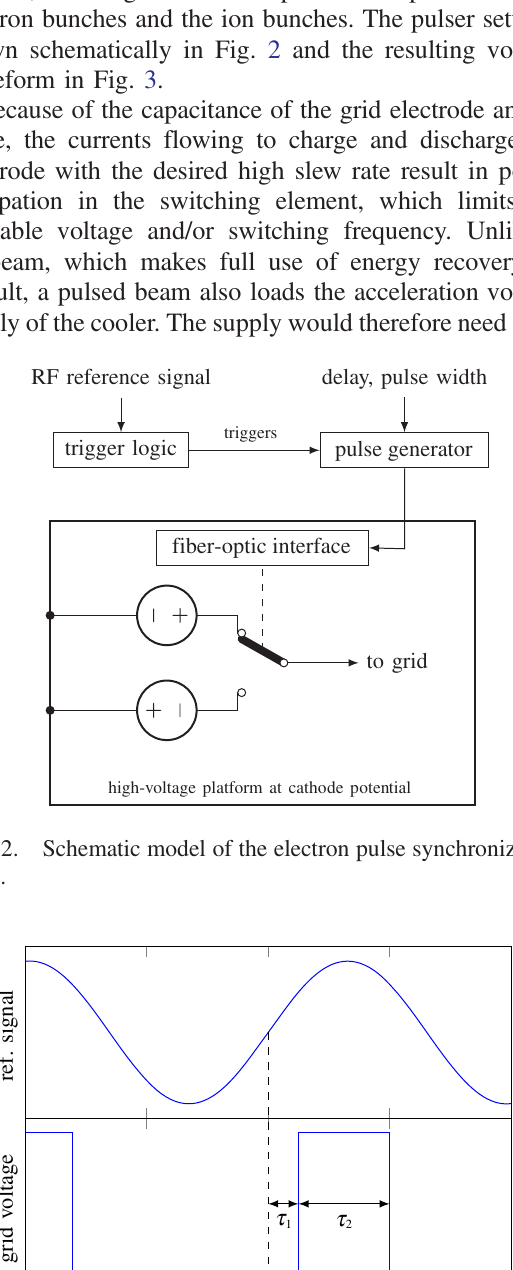
FIG. 3. Sketch of the fixed phase relation between the rf reference signal and the electron gun grid voltage. The delay τ τ 1 and the bunch length 2 are set independently.